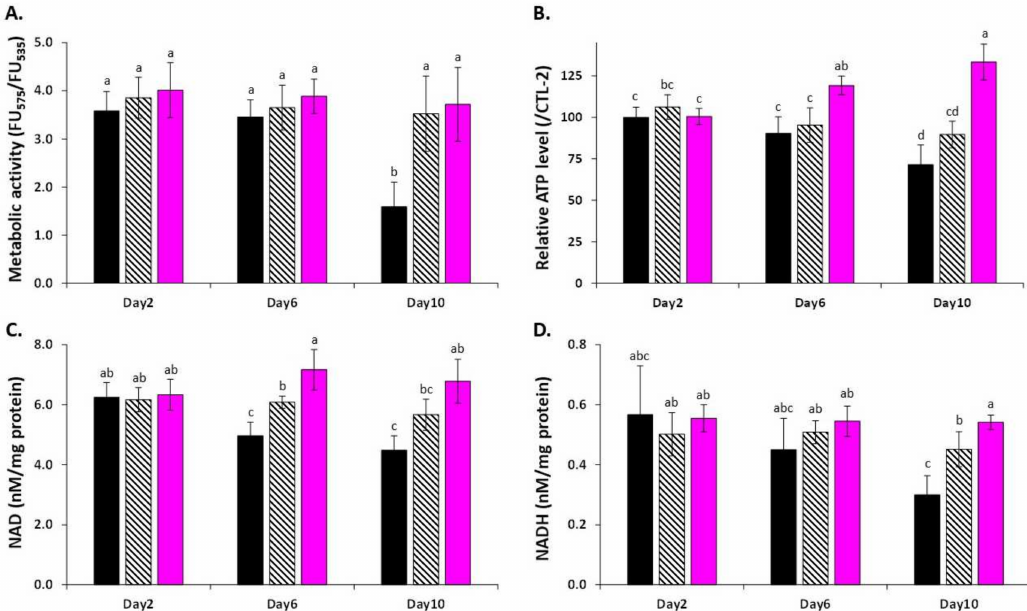
Figure 5. Impact of LSE on central metabolism. ( A ) metabolic activity determined using the FUN-1 probe, ( B ) ATP production, ( C ) NAD level, and ( D ) NADH level. LSE: sacred lotus stamen extract (0.5 mg/mL). RES: E-Resveratrol (10 µ M) used as positive antiaging control. Significant differences ( p < 0.05) are shown by different